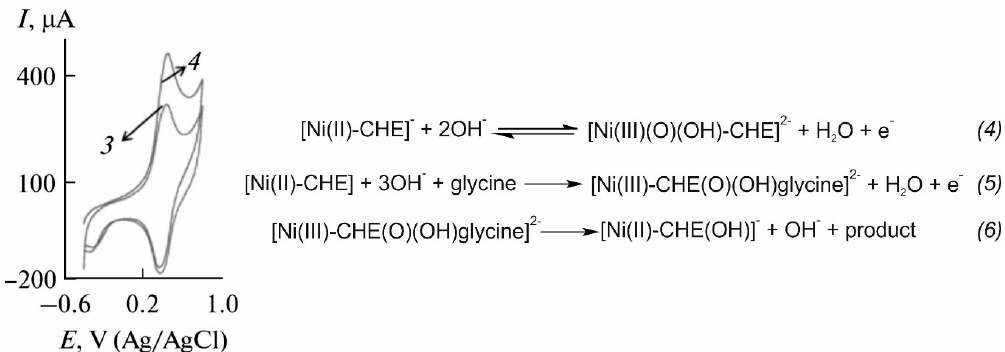
Figure 4. Reactions involved in the determination of glycine using a Ni(II) chelidamic acid-modified electrode with the expected cyclic voltammograms in the absence ( reaction 4 , curve 3) and presence ( reactions 5 and 6 , curve 4) of glycine. (The plot for the voltammograms on the left is reproduced from reference [61] with permission from Springer, Copyright 2020).